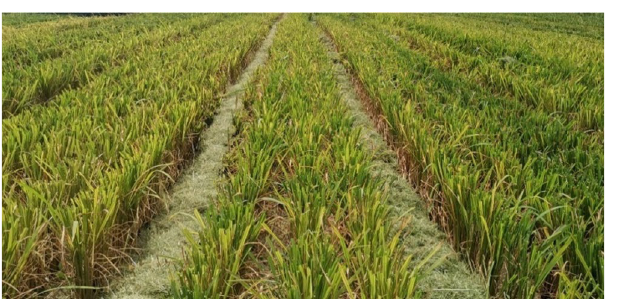
Figure 13. Scattering performance in the field.